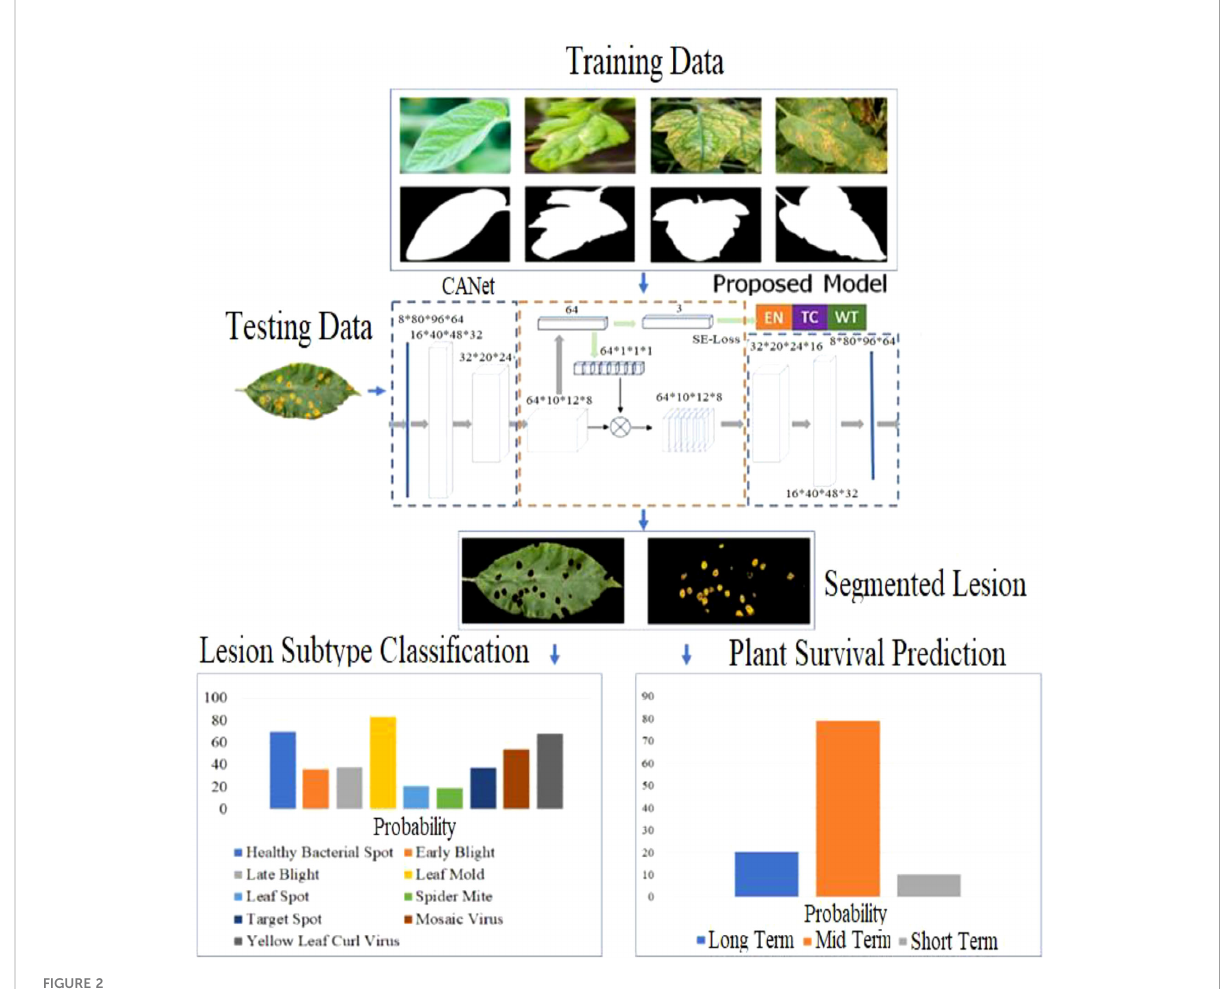
FIGURE 2 Overview of the methodology and overall work fl